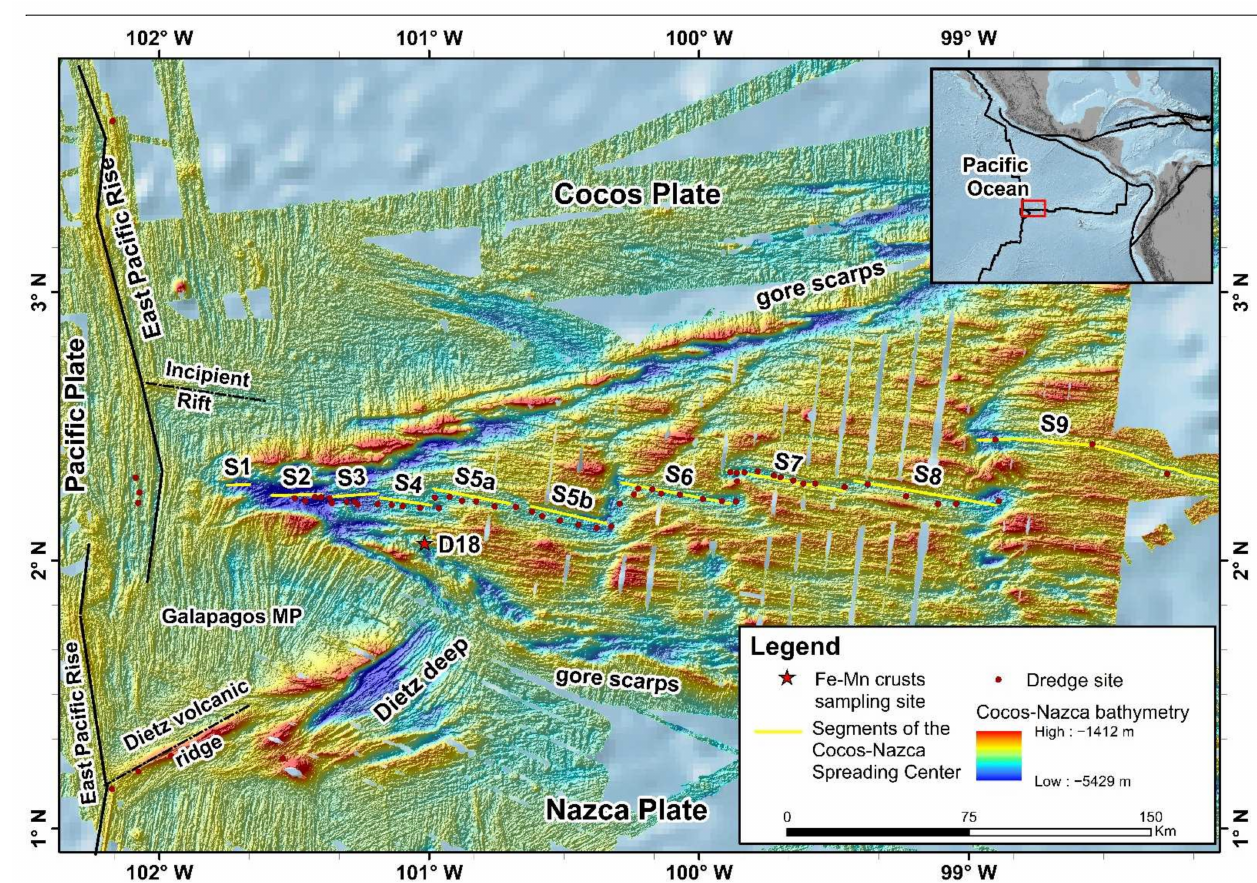
Figure 1. Location of the Fe-Mn crusts sampling site (D18) within the Cocos-Nazca Spreading Centre. Segments described in the text are marked from s1 to s9. Bathymetric data after